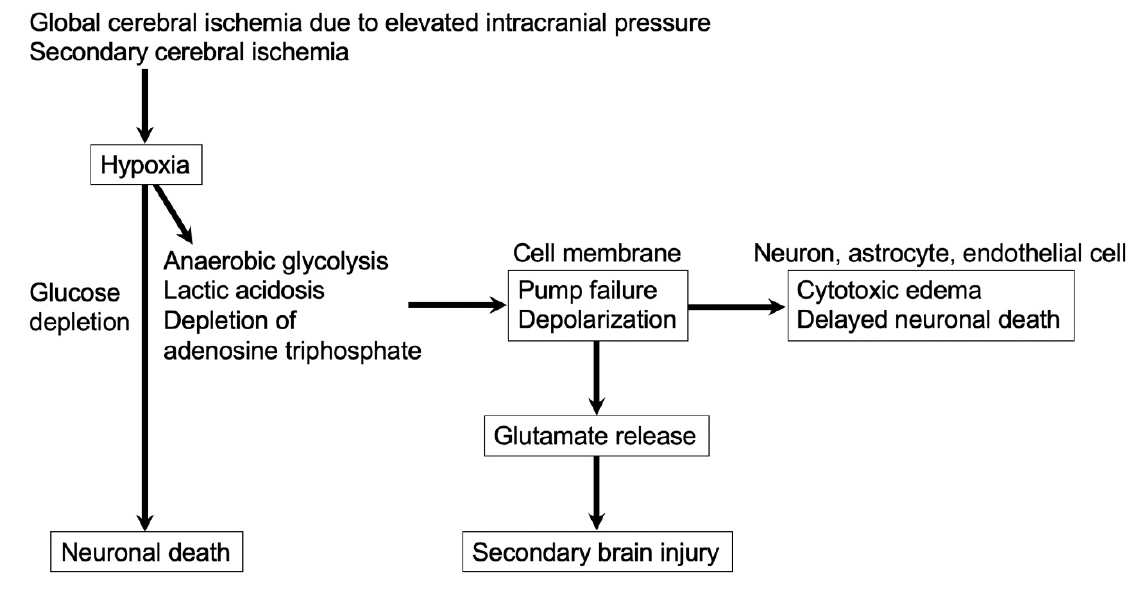
Figure 1. Glutamate release at the rupture of intracranial aneurysm. Released glutamate causes secondary brain injury.